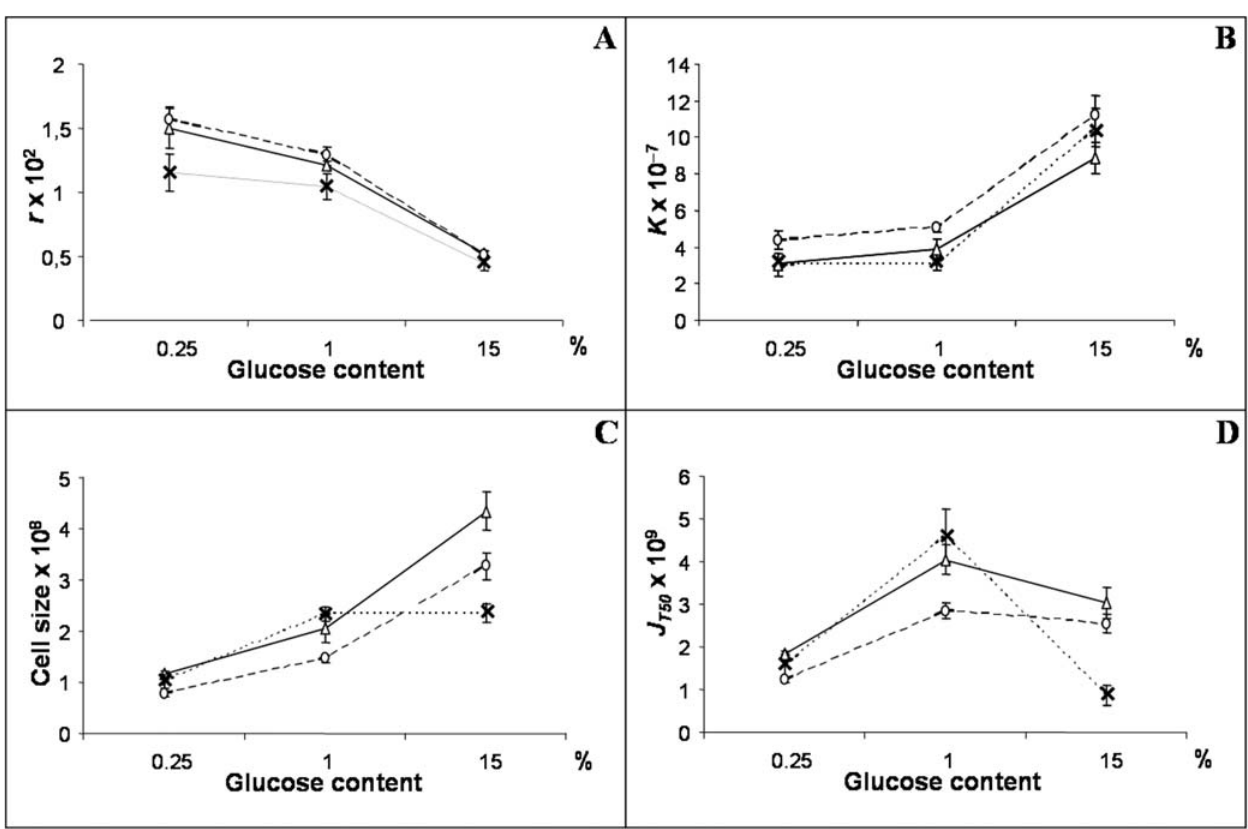
Figure 1. Variation of intrinsic growth rate r (A), carrying capacity K (B), cell size (C) and glucose consumption rate J T50 (D) in three culture media differing for glucose content. Each point represents the mean value of the trait for each industrial origin in each culture medium with the standard error associated. Vinery strains are represented by circles, brewery ones by crosses and bakery ones by triangles.